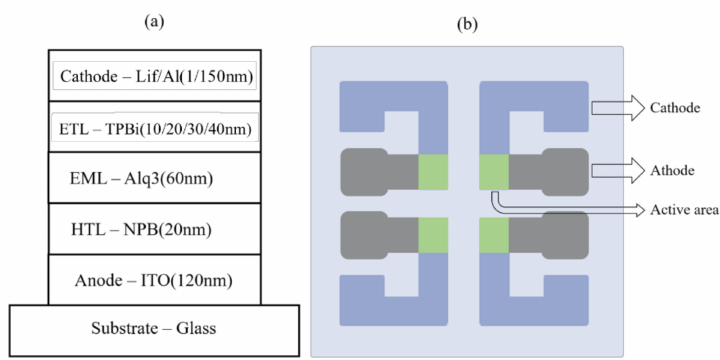
Figure 1. The device structure employed as a ( a ) cross section, ( b ) schematic